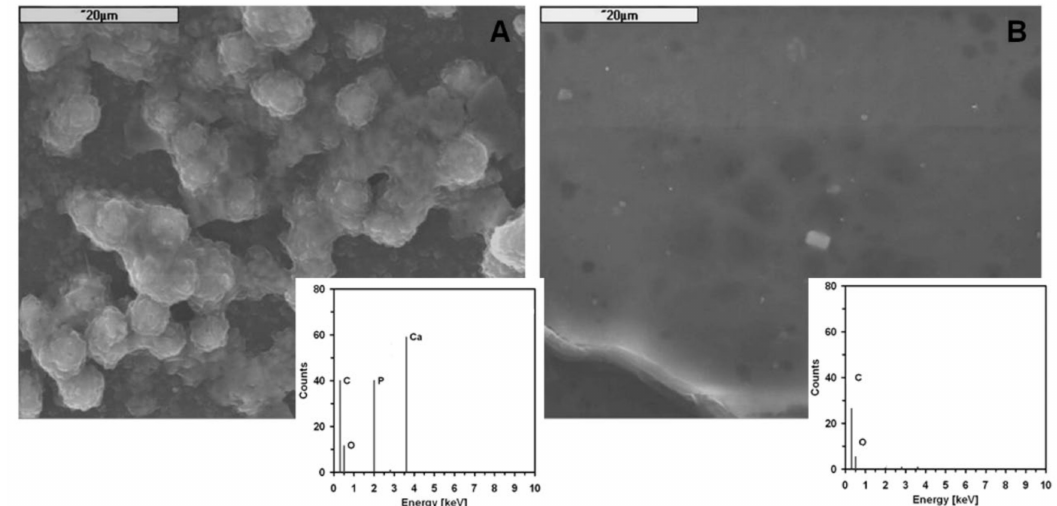
Figure 6. SEM microphotographs of the surface of composites containing 0.5 wt.% of: hss-SiO 2 ( A ) and lss-SiO 2 ( B ) and EDS analysis of the surface of the composite after SBF/3 days/ 37 ◦ C.